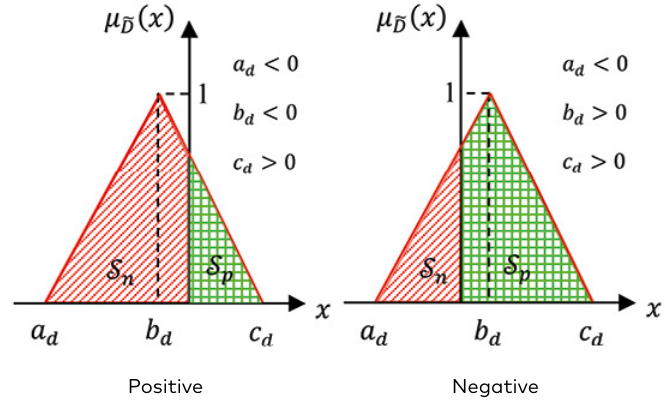
Figure 2. The graphical representation of Area-Based Deviation in